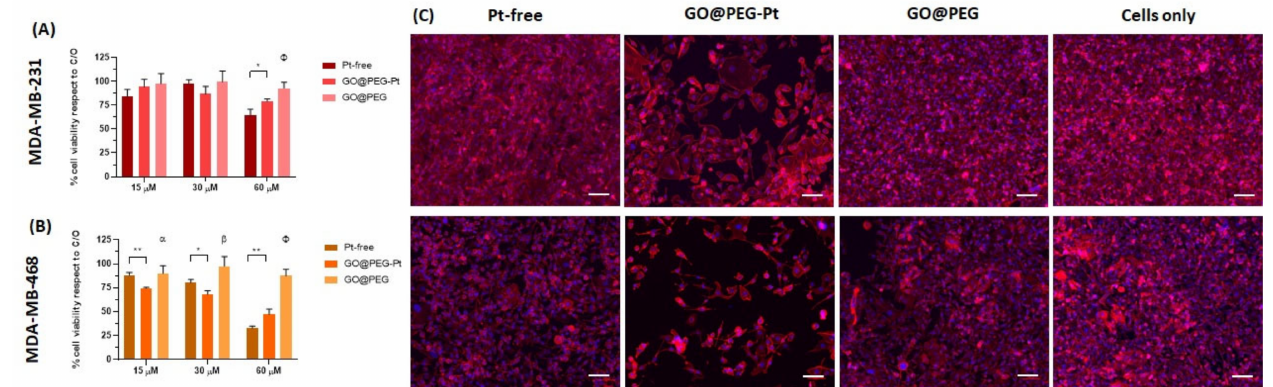
Figure 5. Cell viability and morphological analysis in glioblastoma cell lines. An MTT assay was performed after 72 h of cell culture. The data show the percentage of viable cells compared to cells alone as the control, and the mean ± standard error of the mean is presented. The graphs show the viability of the U87 cell line ( A ), the U118 cell line ( B ) and the respective morphological images of the cells cultured for 72 h in the presence of the 30 mM concentration. Phalloidin red stains for actin filaments, and DAPI blue stains for cell nuclei ( C ). Scale bars: 100 µ m. (* p -value ≤ 0.05; ** p -value ≤ 0.01). Significant differences between GO@PEG and the other compounds are reported in the graph as follows, a: GO@PEG vs. Pt-free p -value ≤ 0.01 in U87; GO@PEG vs. GO@PEG-Pt